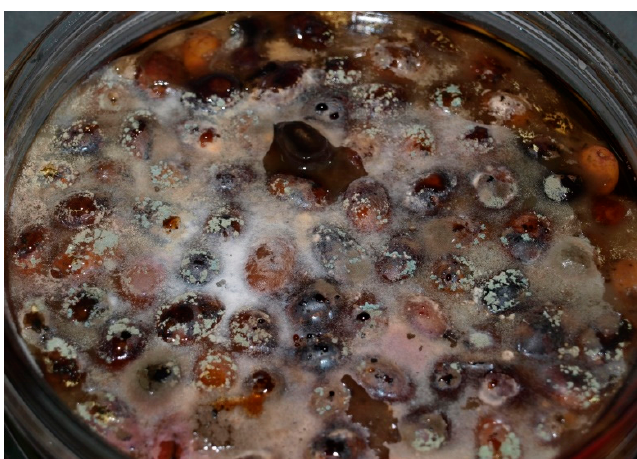
Figure A2. Modified industrial barrel with air-protected headspace.